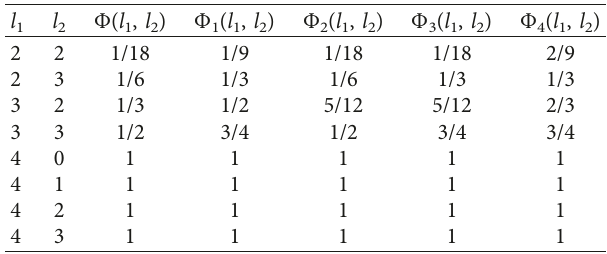
Table 5: Survival signature of the system under different swapping